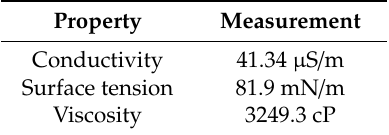
Table 3. Physicochemical properties of the solution.